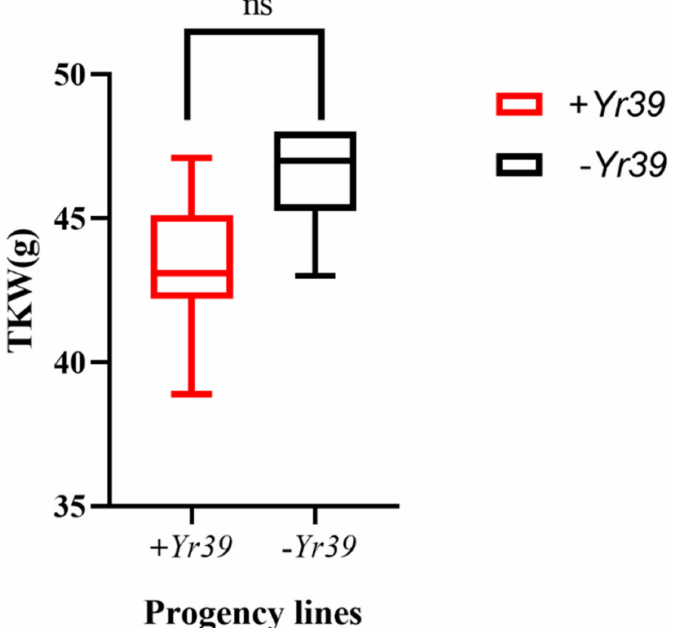
Figure 4. Thousand-seed weight distribution in 4 backcross progeny lines. “+ Yr39 ” represents the presence of Yr39 ; “- Yr39 ” represents the absence of Yr39 ; p -value was generated by the t -test; “ns” represents p > 0.05, no significant